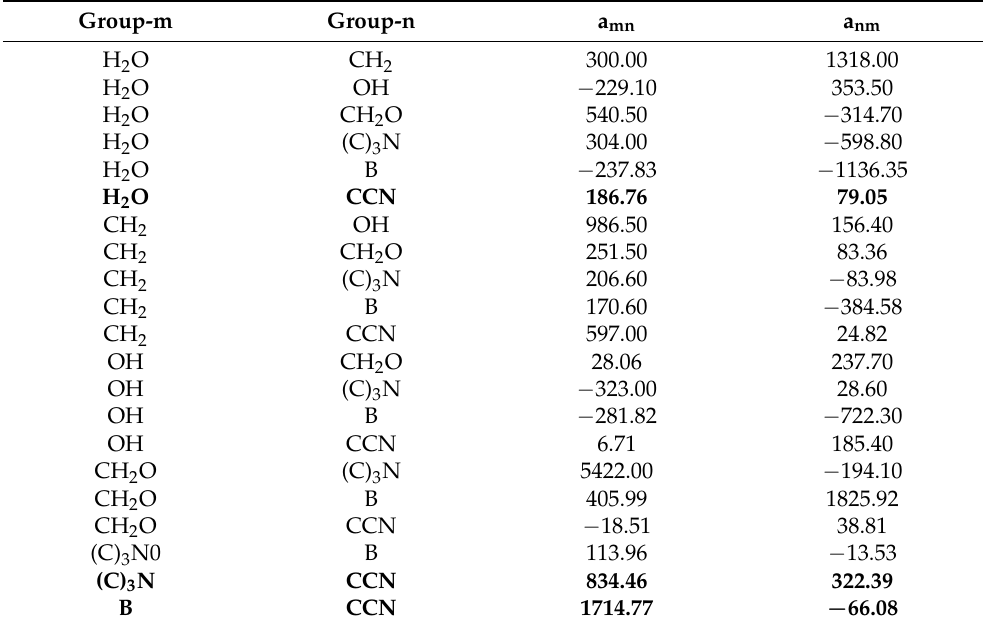
Table 2. Energy parameters of group